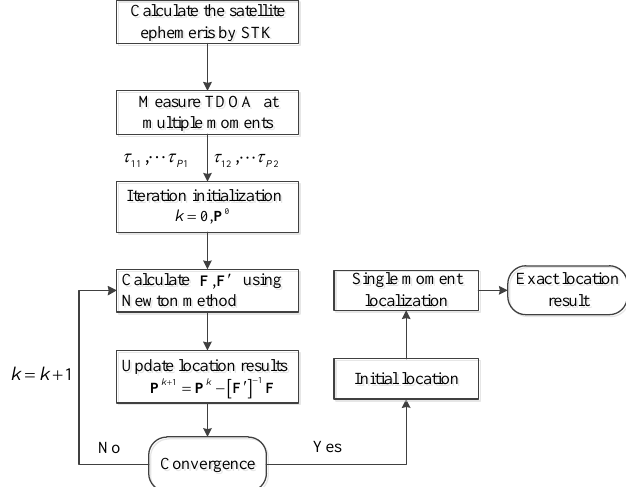
Figure 3. The flow chart of the tri-satellite interference localization.